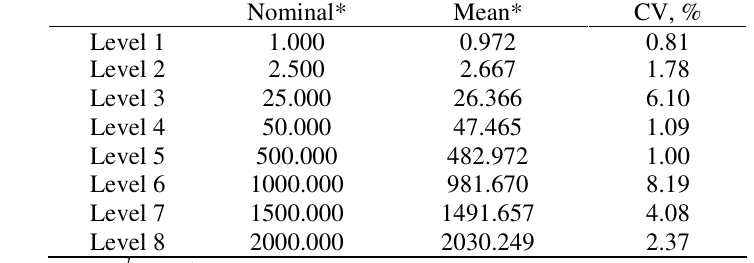
Table 2. Concentrations of metolazone in calibration standards prepared in human plasma.